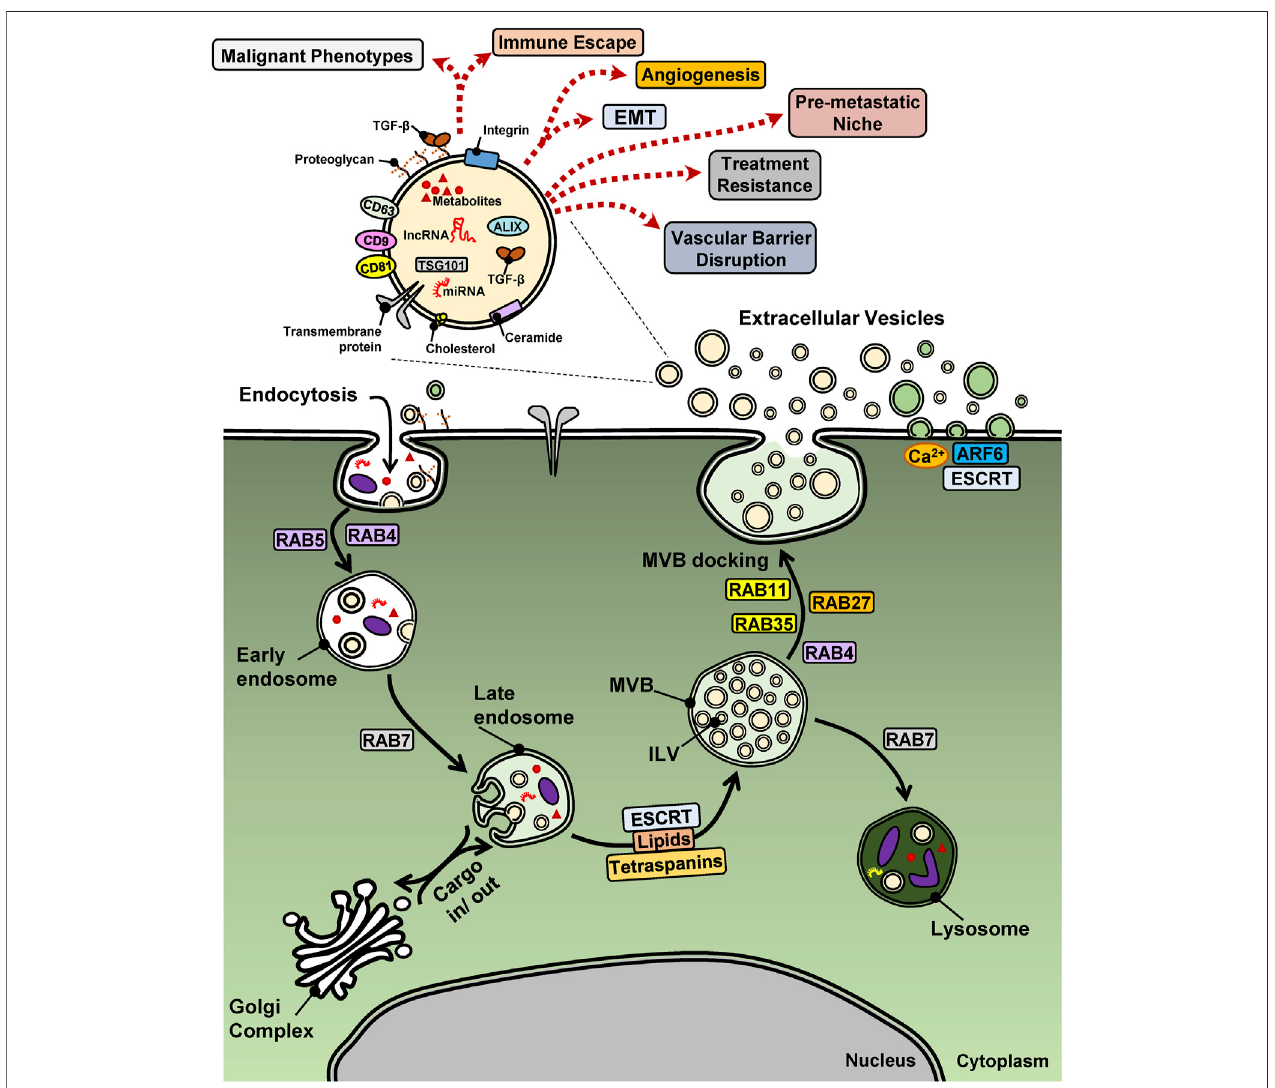
FIGURE 1 | EV biogenesis and biological functions in cancer. A cancer cell is shown with surface proteins and EVs undergoing endocytosis via the early and late endosome and the multi-vesicular body (MVB) that shuttles protein or vesicular (intra-luminal vesicles, ILV) cargo to lysosomes or the cell surface, thus releasing exosomes (beige EVs), meanwhile outward budding of the plasma membrane releases microvesicles (green EVs). The case of apoptotic bodies generated from cells undergoing cell death is not illustrated. Key regulatory proteins of endocytosis and EV biogenesis are shown with their names boxed. A single EV is magni fi ed in order to highlight various cargo molecules. miRNAs and lncRNAs may be viewed with potential caution as to their functional importance as EV cargo. Dotted arrows indicate diverse cell biological functions of EVs that relate to the hallmarks of cancer.